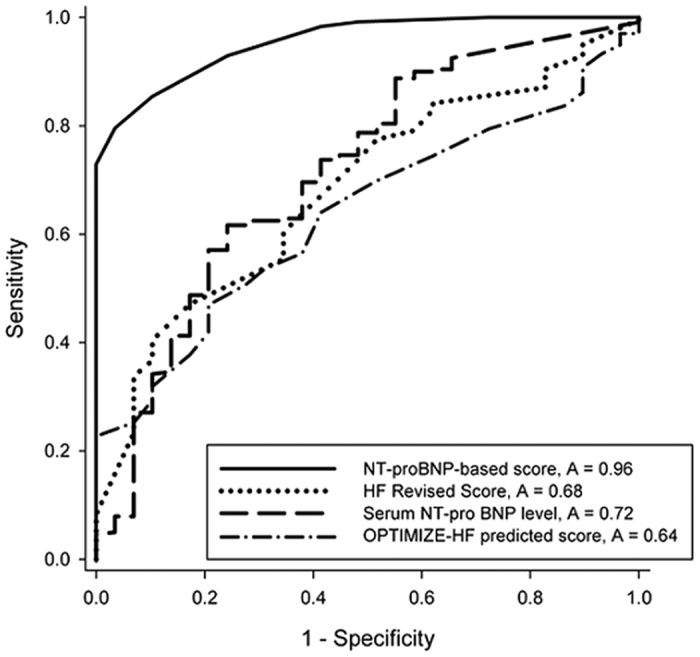
Better predictability for in-hospital mortality of NT-proBNP-based score comparing with serum NT-proBNP level, HF revised score, and OPTIMIZE-HF score.Note: Solid line denotes NT-pro BNP-based scores, with Area Under the Curve (AUC) of 0.96 (95% Confidence Interval (CI): 0.92–0.98, p-value < 0.0001); sensitivity of 0.97, specificity of 0.80, Positive Predictive Value (PPV) of 0.36, Negative Predictive Value (NPV) of 1.00, accuracy of 0.94. Dashed line denotes serum NT-pro-BNP levels, with AUC of 0.72 (95% CI: 0.66–0.77, p < 0.001), sensitivity of 0.76, specificity of 0.62, PPV of 0.19, NPV of 0.96, and accuracy of 0.64. Dotted line denotes HF revised score9, with AUC of 0.68 (95% CI: 0.59–0.78, p = 0.001). Dash-Dotted line denotes OPTIMIZE-HF score4, with AUC of 0.64 (95% CI: 0.55–0.73, p = 0.014). The AUC of NT-pro-BNP based score was higher than that of the serum NT-pro-BNP level, HF revised score9 and OPTIMIZE-HF score4 (p < 0.0001), while the AUC of serum NT-pro-BNP level was higher than the HF revised score9 and OPTIMIZE-HF score4 (p < 0.0001).